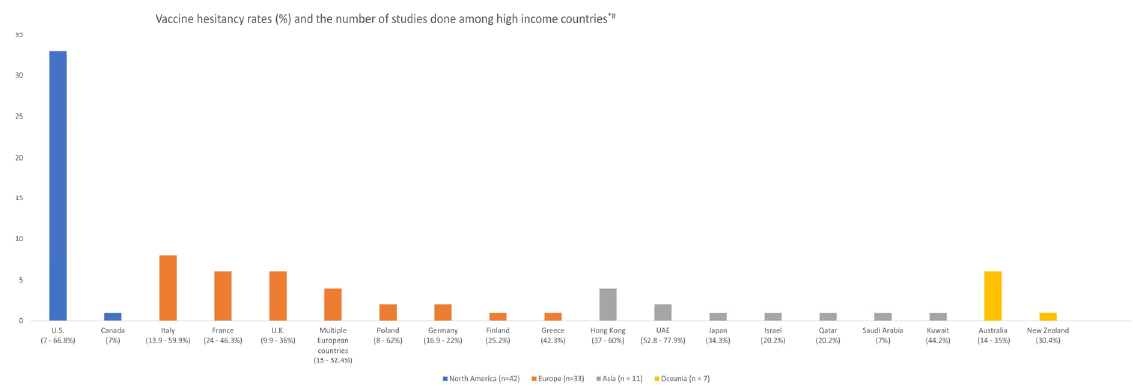
Figure 2. Studies on vaccine hesitancy and its corresponding rates among high income countries. * Only studies with reported vaccine hesitancy rates were included in Figure 2. # 4 studies performed in multi ‐ continents not included to prevent double counting. Abbreviations: U.S. — United States; UAE — United Arab Emirates